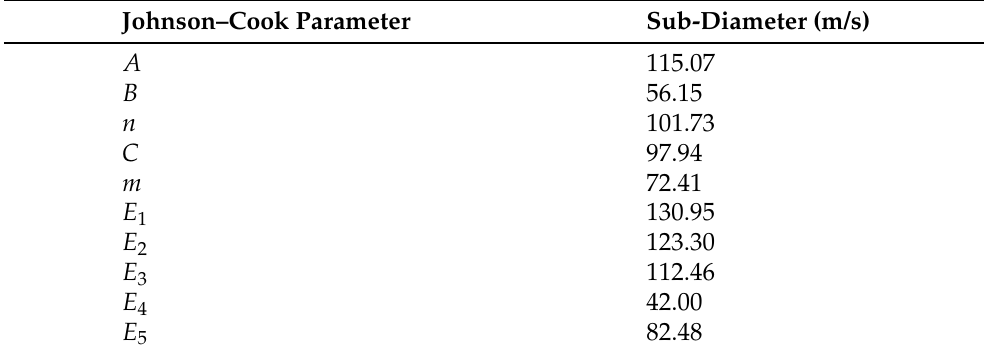
Table 5. Sub-diameters of Johnson–Cook parameters. The total diameter is 300.97 m/s, to which the plasticity and fracture models contribute 203.91 m/s and 221.37 m/s,